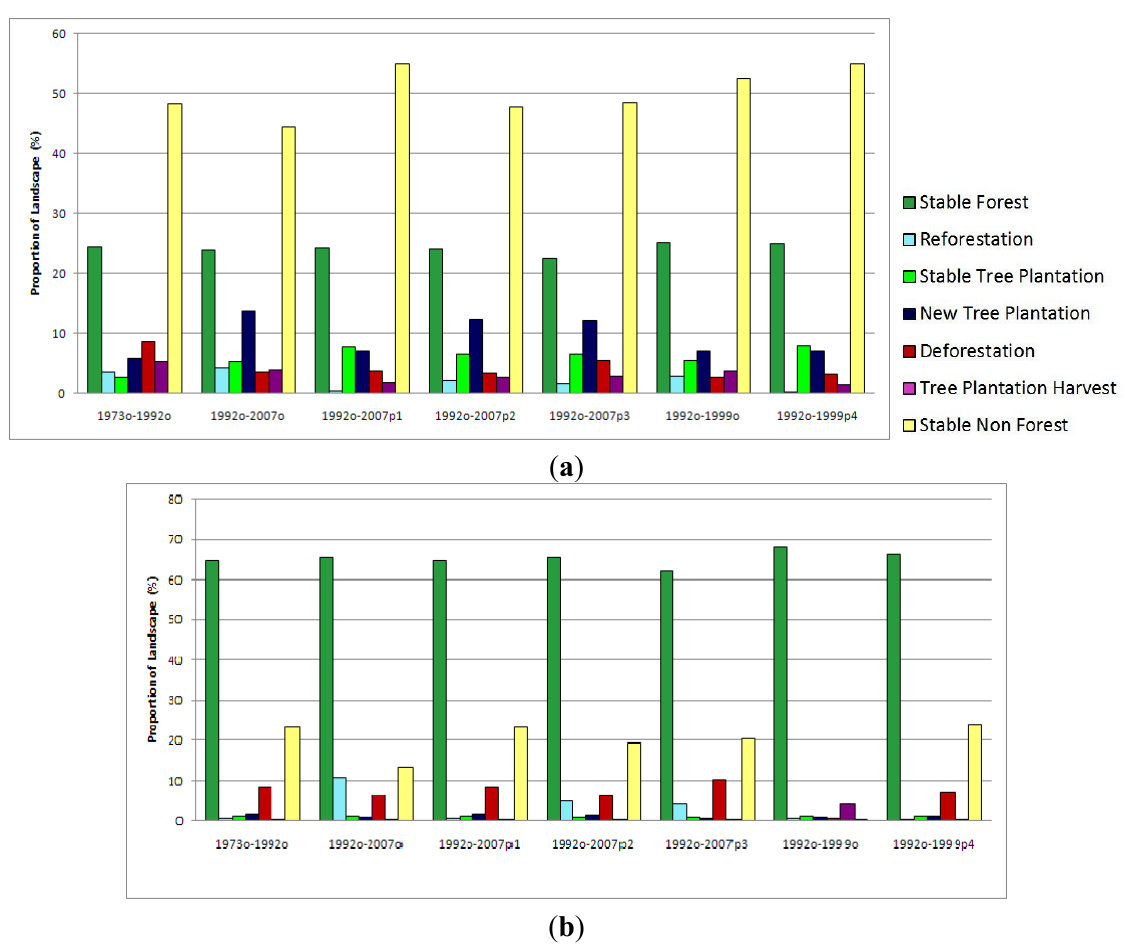
Figure 6. Two-date change trajectories observed vs. predicted land cover transition for ( a ) BNP and its surroundings, ( b ) BNP and ( c ) Buffer Map showing the study area with Park boundary and a buffer of 5 km from the park